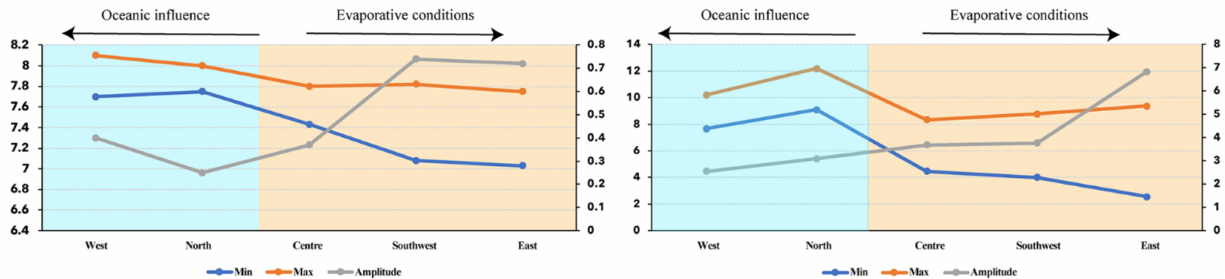
Figure 2. Characteristics of the local meteoric water lines (LMWL) in Romania. The left panel shows the minimum and maximum values for the slopes, and the right panel shows the minimum and maximum values for the